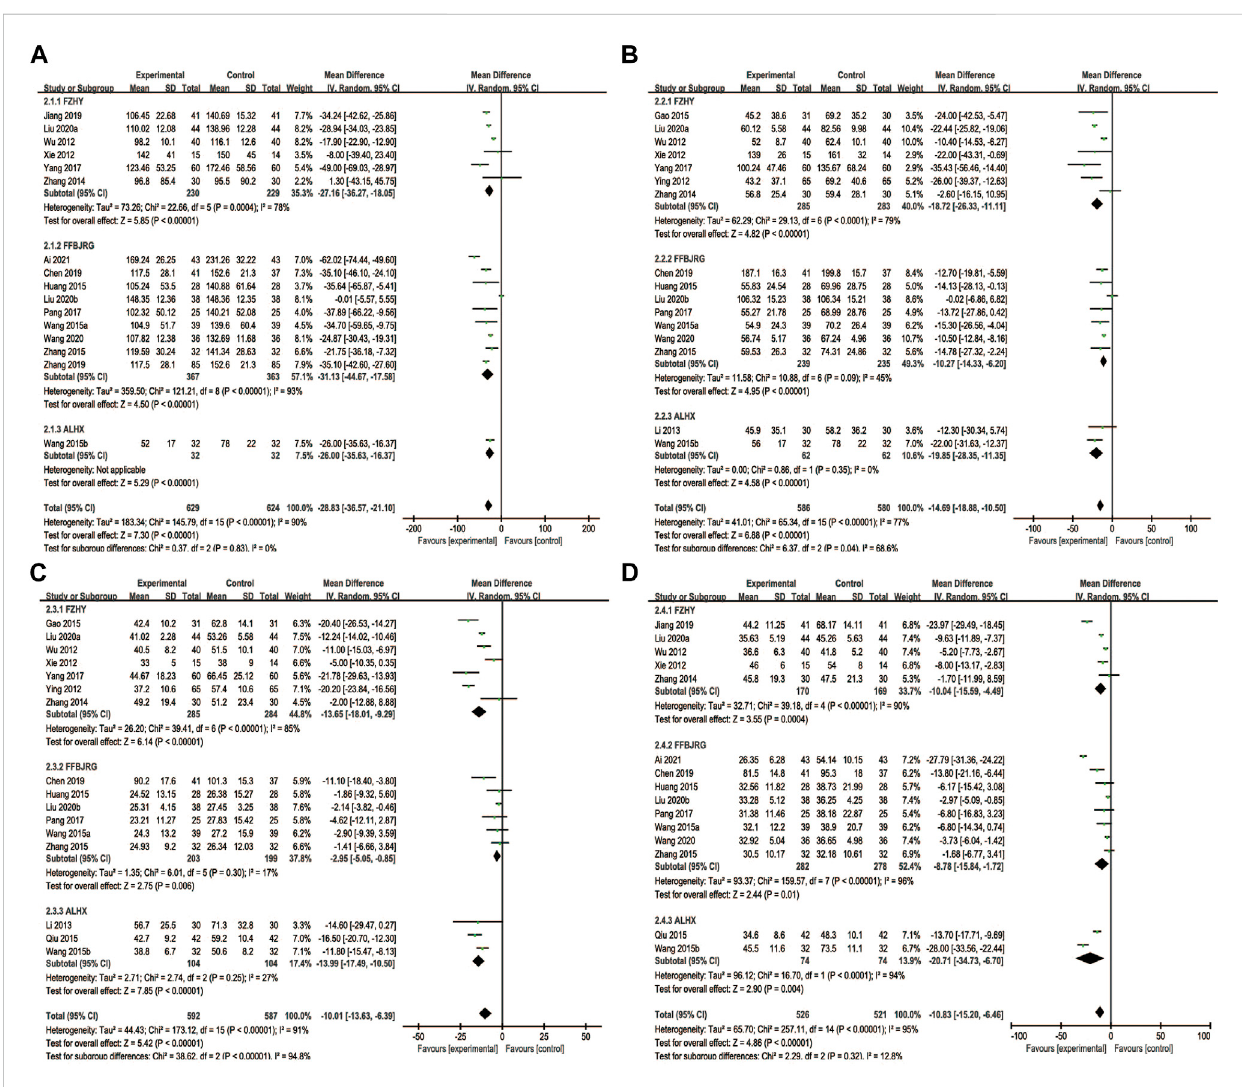
FIGURE 5 Forest plot of meta-analysis of liver function (A) alkaline phosphatase; (B) gamma-glutamyl transpeptidase (C) alanine aminotransferase; and (D) aspartate aminotransferase.